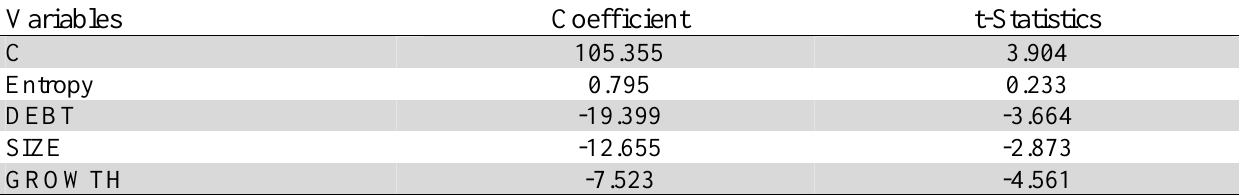
Cross- section Fixed effects of Hypothesis